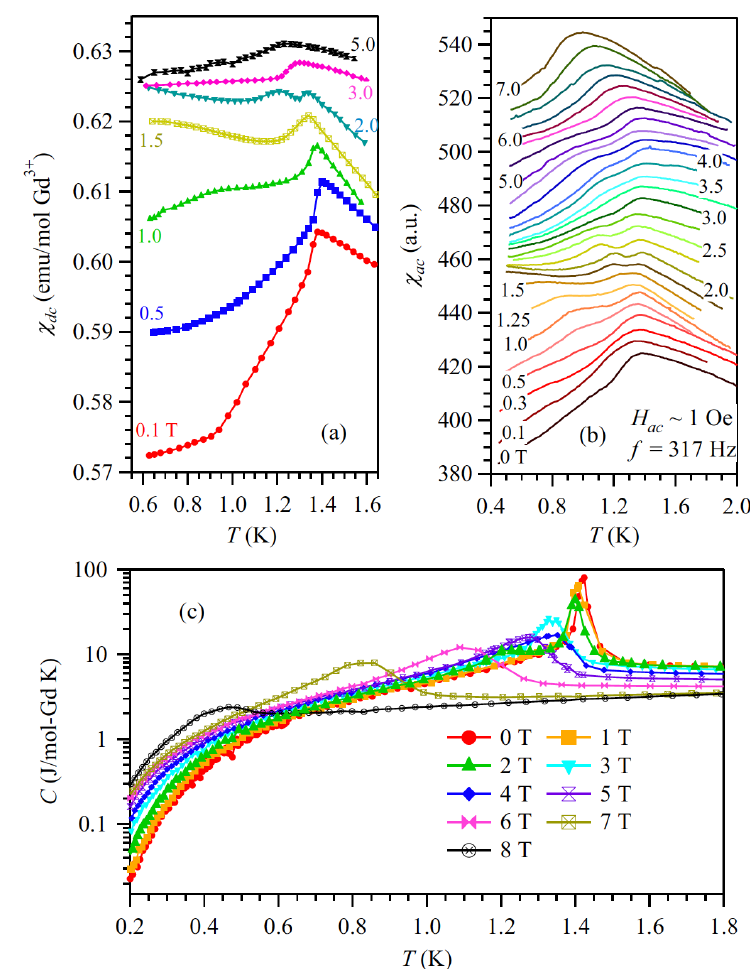
Figure 2. (color online) Temperature dependence of ( a ) dc magnetic susceptibility ( χ dc ), ( b ) ac magnetic susceptibility χ ac , and ( c ) specific heat ( C ) under various fields for Gd 2 Ge 2 O 7 . From Ref. [12].